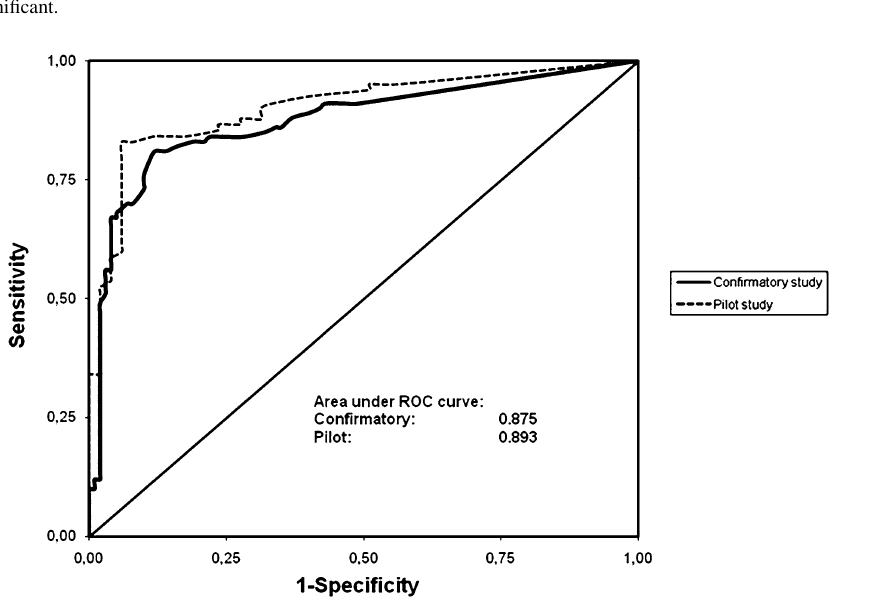
Fig. 1. Receiver operating characteristic (ROC) curve of FL-DNA analysis of the pilot and confirmatory studies.